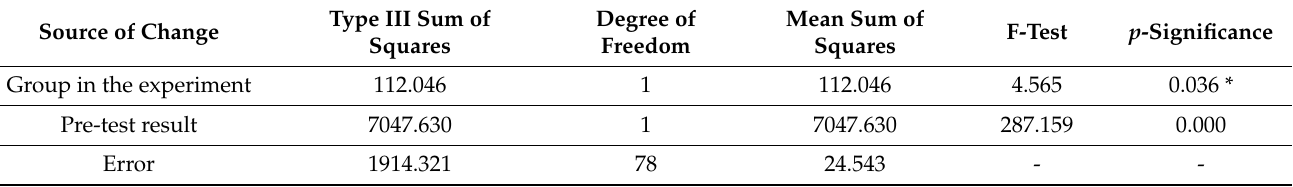
Table 10. Summary table of covariance analysis.